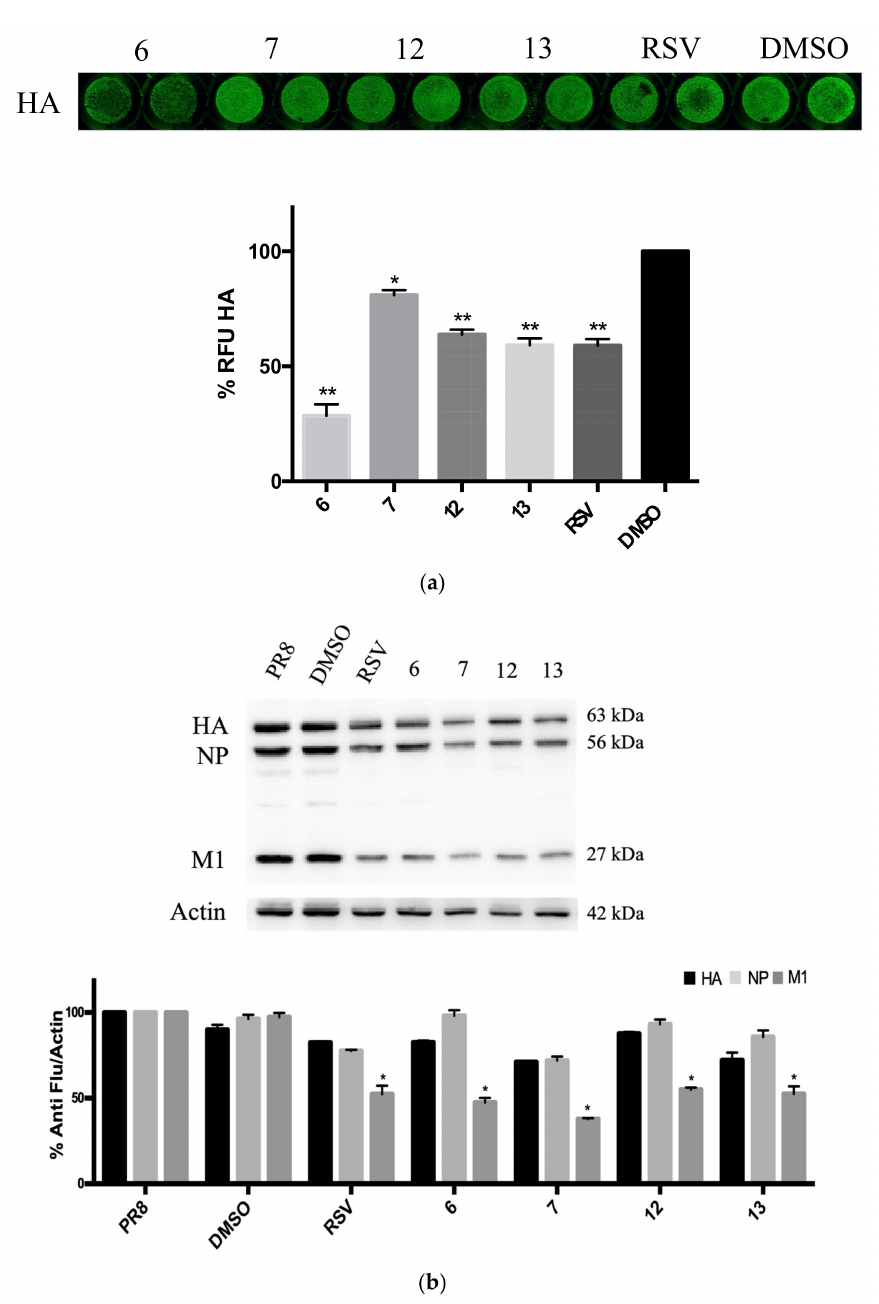
Figure 3. RSV derivatives 6 , 7 , 12 , and 13 decrease viral proteins synthesis. ( a ) In-Cell Western assay of hemagglutinin (HA) protein expression in influenza A PR/8/H1N1 virus-infected A549 cells treated with the RSV derivatives (compounds 6 , 7 , 12 , and 13 ) or with RSV at a concentration of 20 µ g/mL. Cells treated with solvent (DMSO) were used as control. The graph represents the per- centage (%) of the Relative Fluorescence Unit (RFU) obtained from viral HA protein expression compared with DMSO (considered 100%). Data are expressed as means ± S.D. of two experi- ments, each performed in duplicate ( n = 4) (* p < 0.05, ** p < 0.001 vs. DMSO-treated condition). ( b ) Western blot analysis of influenza A virus proteins, hemagglutinin (HA), nucleoprotein (NP), or matrix protein 1 (M1) immunostained with anti-Flu. Actin was used as loading control. The blot shown is one representative of three performed. In the panel below, densitometry analysis of HA, NP, and M1 protein expression is shown. Data are expressed as ratio of each viral protein to actin (* p < 0.05 vs.